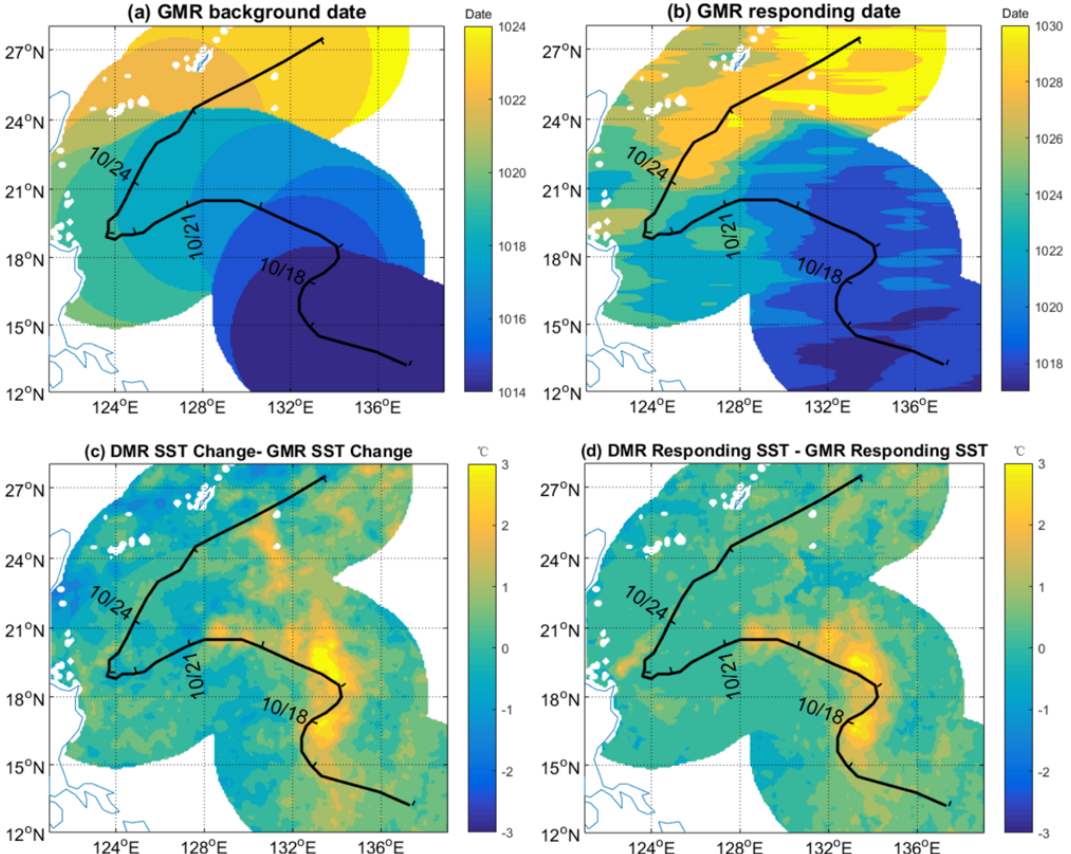
Figure 6. ( a , b ) The background and responding dates calculated by GMR method. ( c ) The SST cooling difference between DMR and GMR methods. ( d ) The SST change (recovery) from the grid-based maximum responding time to 24 October.